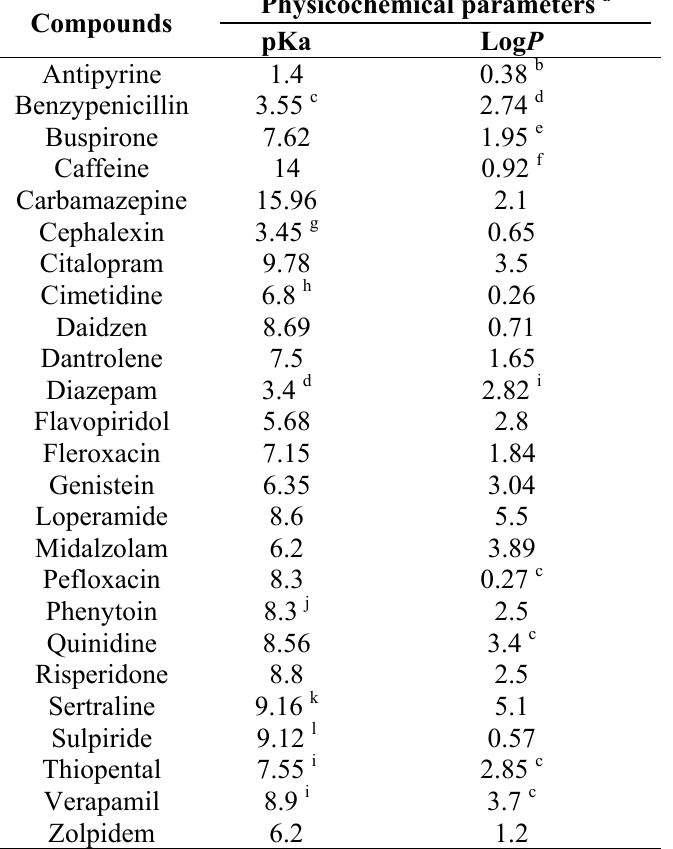
Table S7. Physicochemical parameters used to calculate partition coefficients.